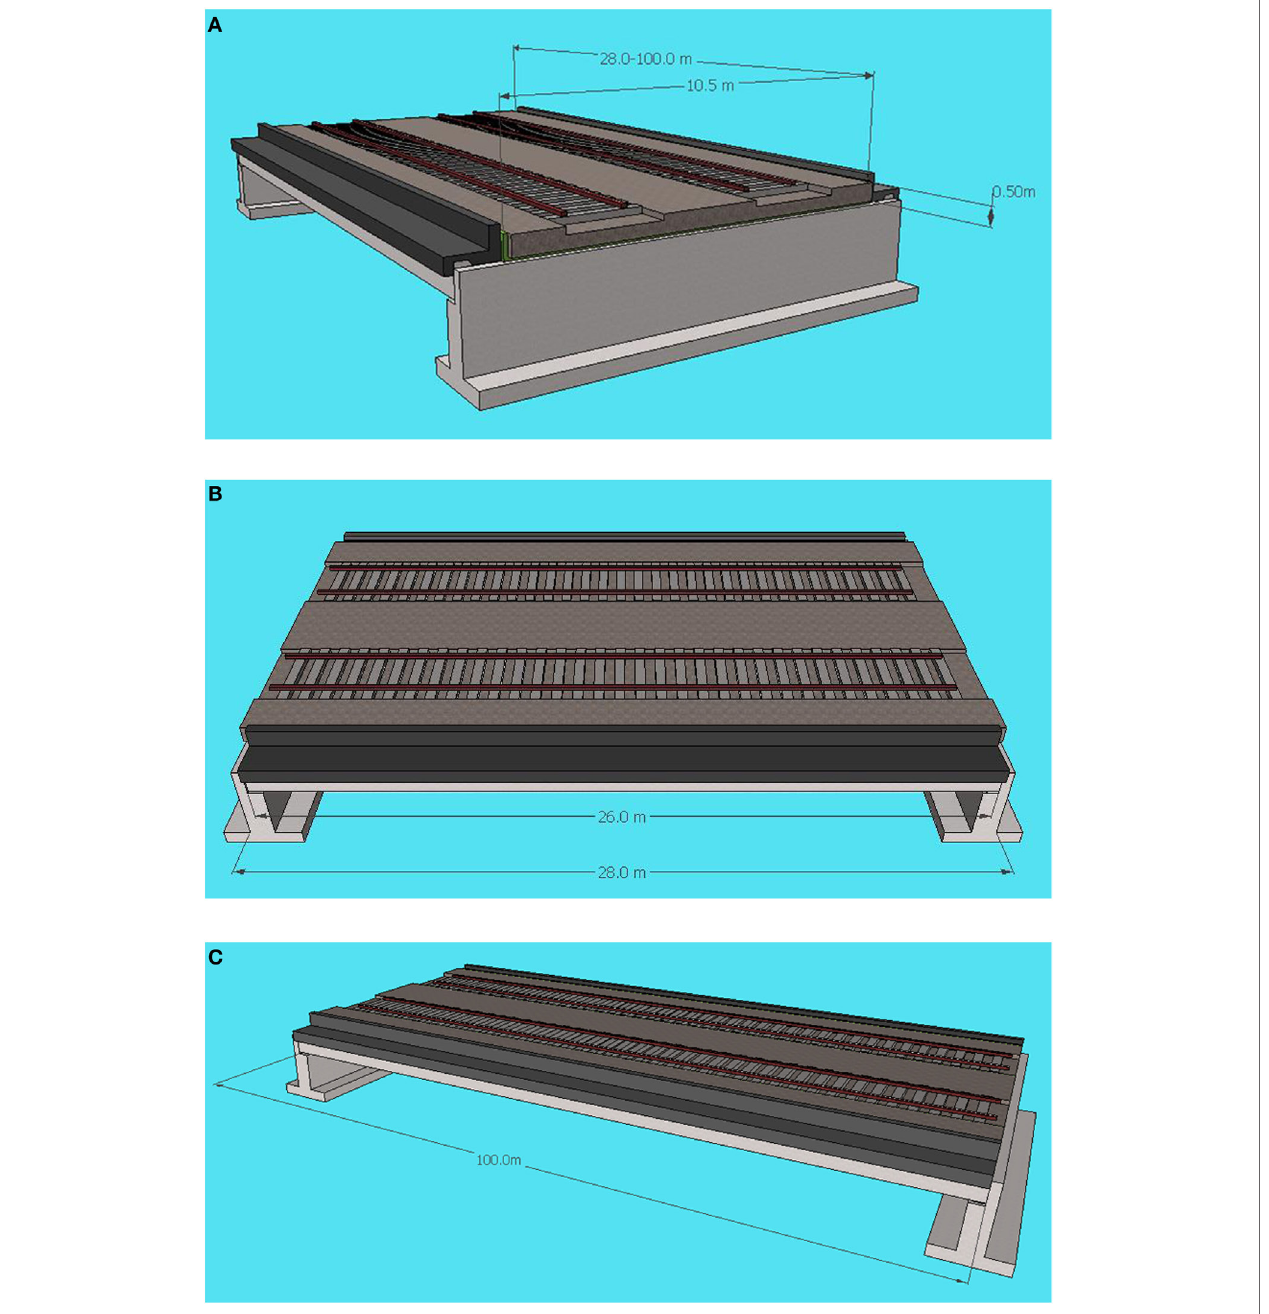
Figure 3 | Longitudinal sections of railway bridge. (a) bridge cross section; (B) longitudinal section of short span bridge; (c) longitudinal section of long span